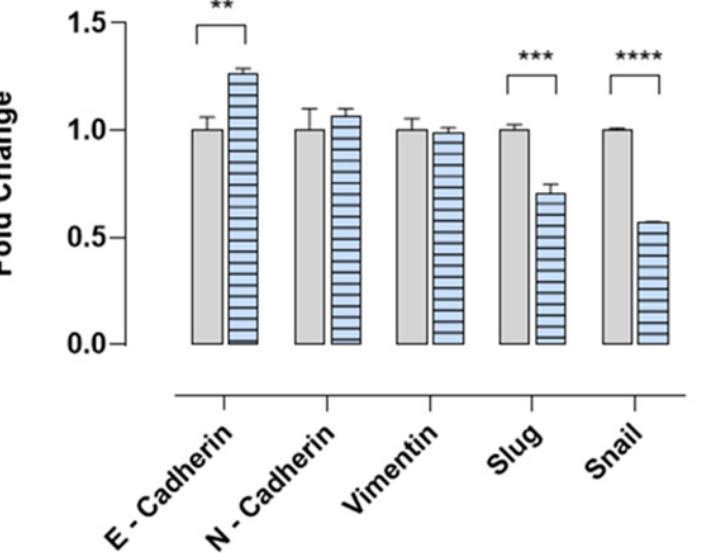
Figure 8. Expression analysis of a limited panel of EMT genes by RT-qPCR following HoThyRu/DOTAP application in vitro. RT-qPCR analysis of the EMT pathway genes E-cadherin, N-cadherin, vimentin, Slug, and Snail, performed on MDA-MB-231 cells treated or not with HoThyRu/DOTAP for 48 h. The mRNA expression levels of each gene were normalized using the GAPDH as a housekeeping gene and are indicated as the fold change with respect to untreated control cultures. Values represent the mean ± SEM of three independent experiments, each per- formed in duplicate. ** p < 0.01 vs. control cells; *** p < 0.001 vs. control cells; **** p < 0.0001 vs. control cells. The report of RT-qPCR analysis is shown in Figure S4.